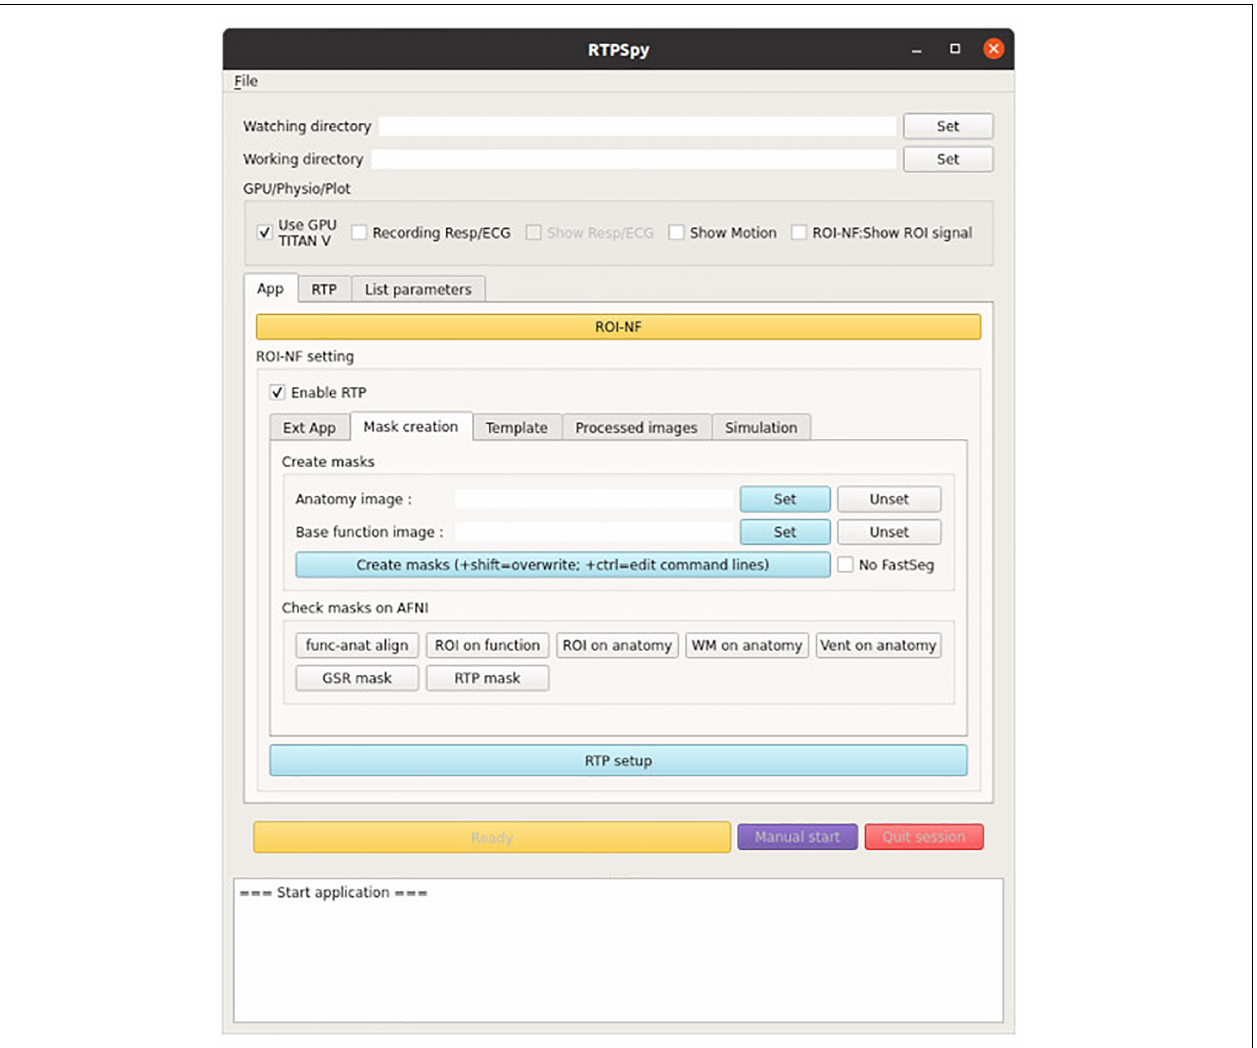
FIGURE 9 | A view of the example GUI application integrating the RTPSpy modules. The figure presents the “ mask creation ” tab to run the make_masks process with GUI. The example application also offers graphical interfaces to almost all parameters in RTPSpy. Detailed usage of the application is presented in GitHub (see text footnote